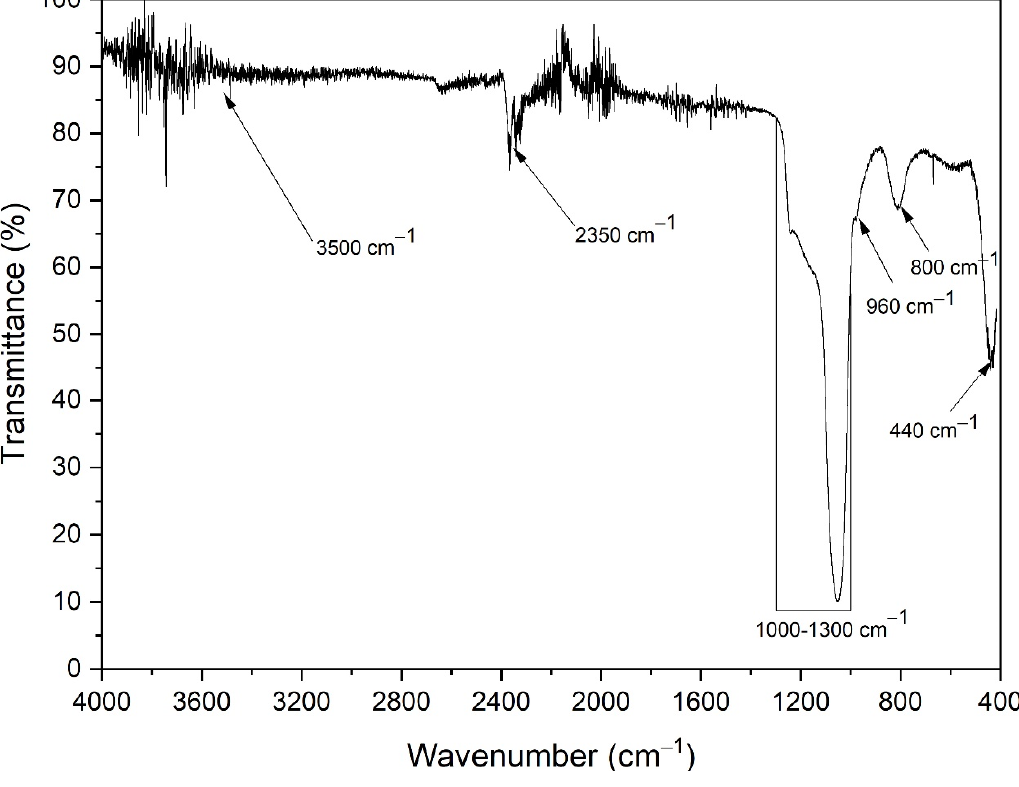
Figure 10. FT-IR spectrum of Ti-MCM-41 catalyst.